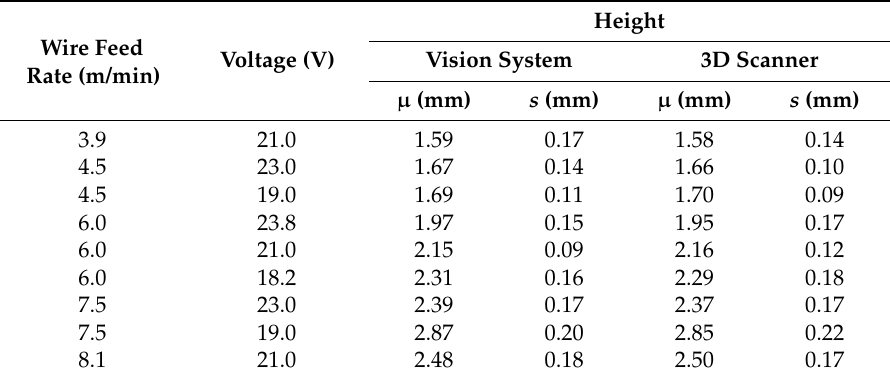
Table 2. Measurement results of height.